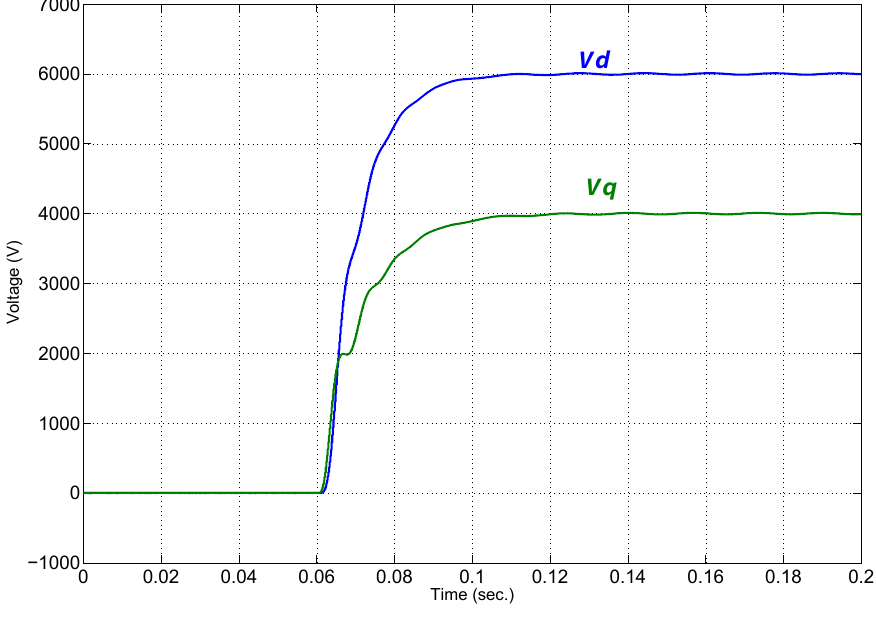
Figure 9. The d and q components of the load voltage generated by the Mat- lab/simpowersystems.